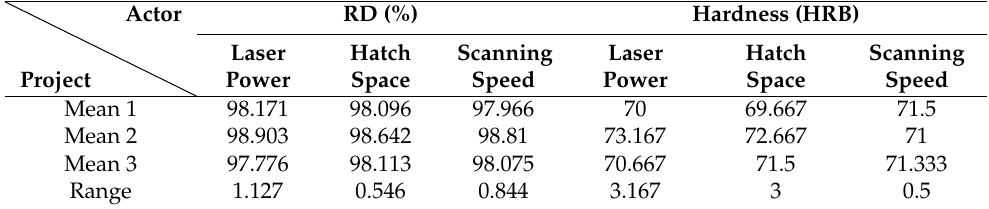
Table 3. The range analysis of the orthogonal experiment.